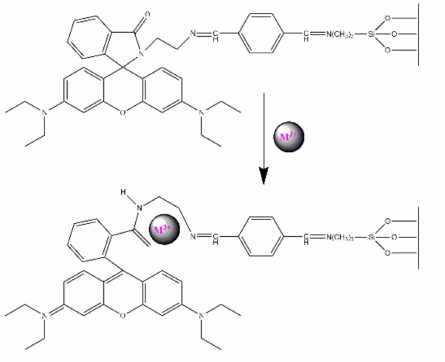
Figure 60. The possible sensing mechanism of RFMS (Table 4, No. 13) to Fe 3+ , Cr 3+ and Al 3+ [118].